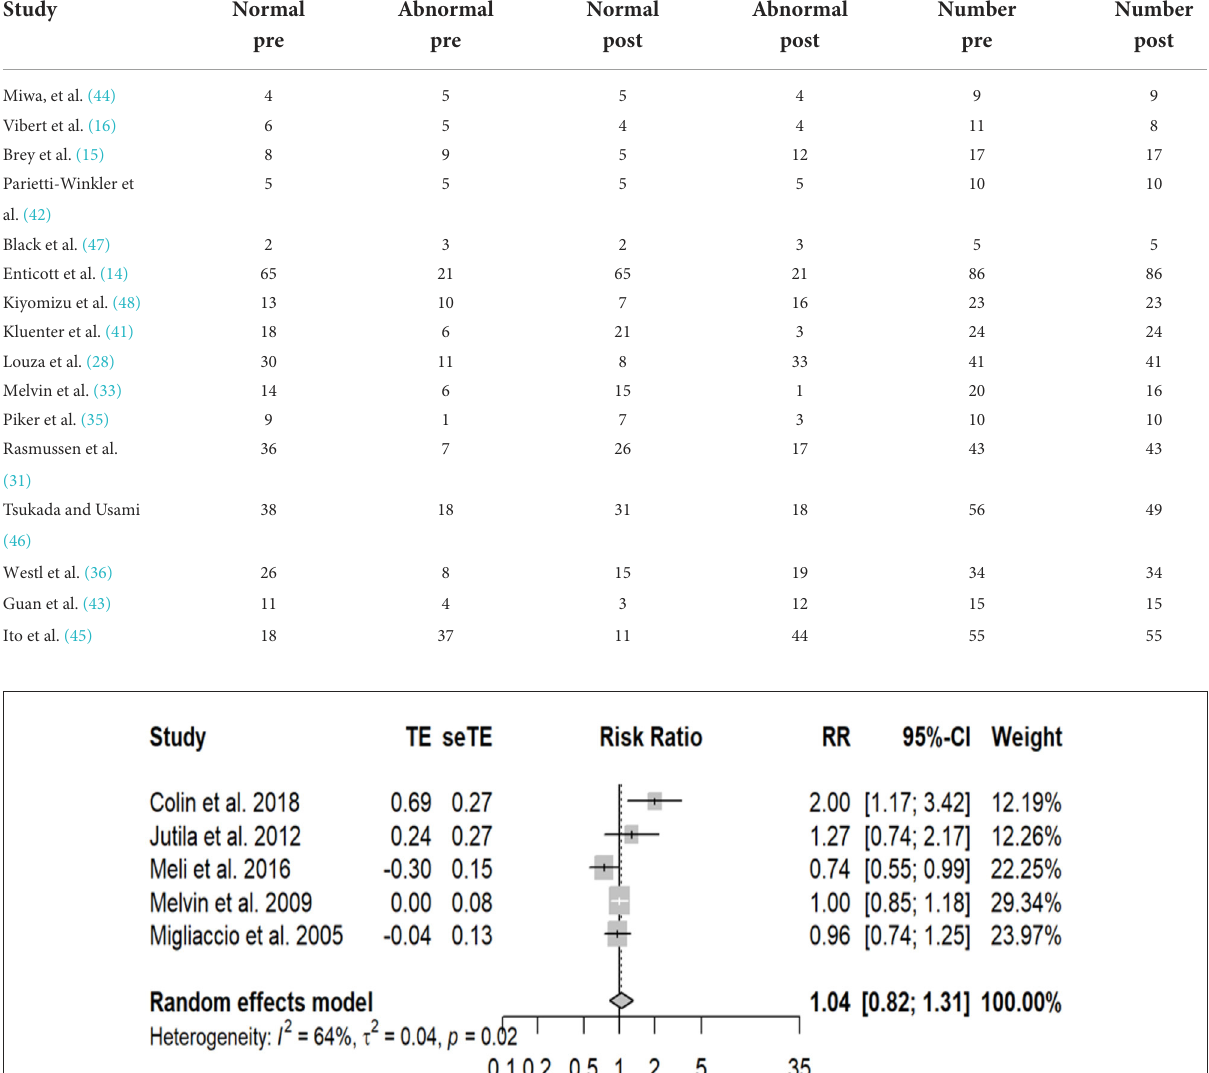
TABLE 3 Number of subjects with normal and abnormal testing results before and after surgery in studies included in the meta-analysis for the caloric test.